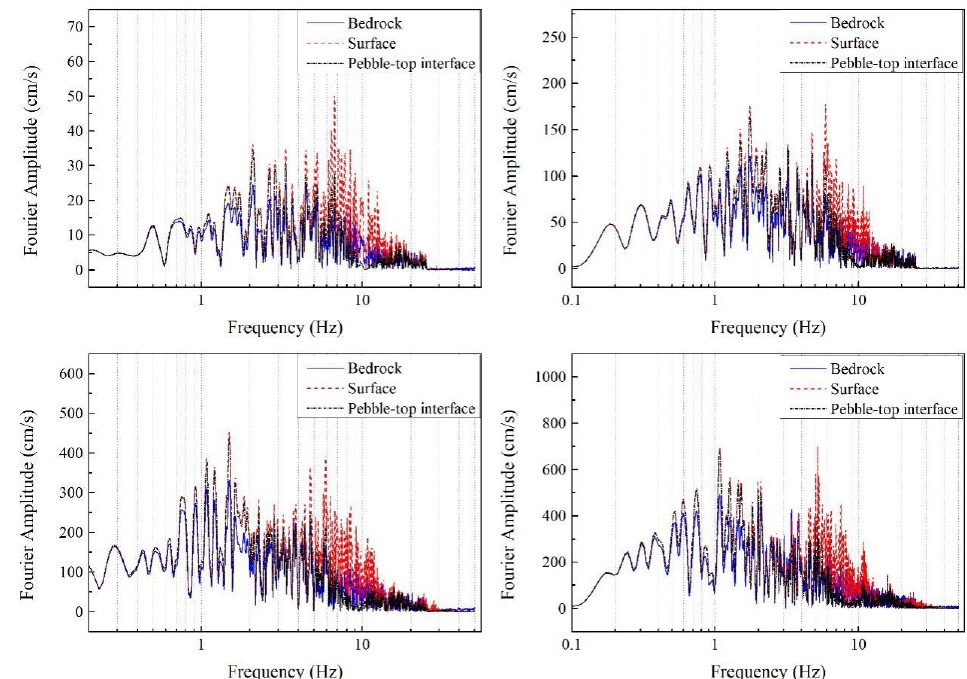
Figure 13. The Fourier spectrum between pebble-top interface and ground surface under four seis- mic inputs.